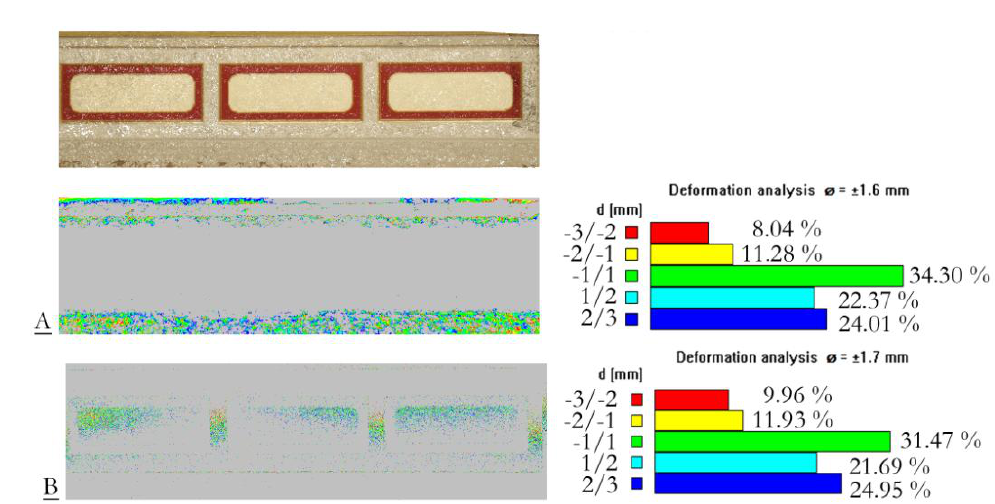
Figure 6 Deviations of points from reference planes. A - the point cloud from image matching, B - the point cloud from terrestrial laser scanning. The null deviations are presented in